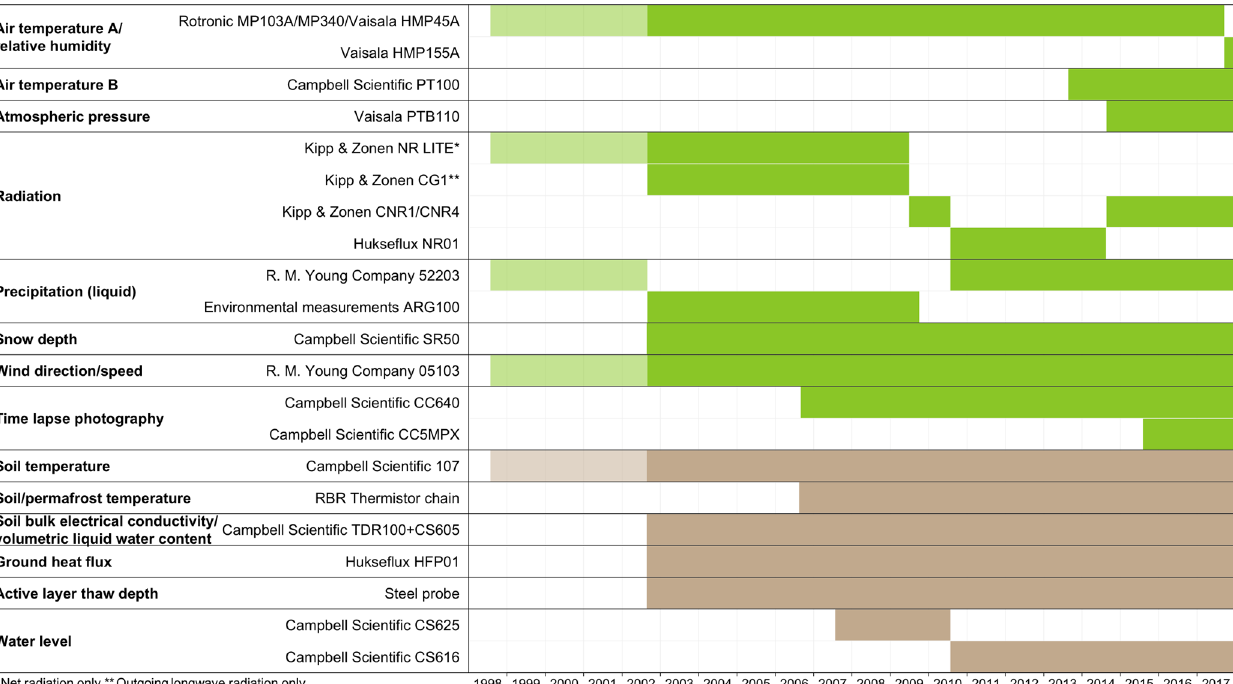
Figure 4. Timeline for all of the parameters recorded at the Samoylov research site between 1998 and 2017. Green bars represent above- ground sensors; brown bars represent sensors installed below the ground surface. Dark brown and dark green colouring indicates a data set described in this paper (2002–2017); light brown and light green colouring indicates a previously described data set (1998–2011; Boike et al., 2013). Continuous data (light and dark coloured data sets, e.g. wind speed and direction) are combined in the level 2 product as one continuous data series for the period 1998–2017. Details of parameters for all sensors can be found in Table 2. Note that the colour bars describe the sensor installation period, but data might not be available in the published data set due to sensor malfunction or failure. Note that the measuring period for the Vaisala HMP155A only started on 17 September, 2017, which is why the bar appears very thin. Recording of all parameters is still continuing at